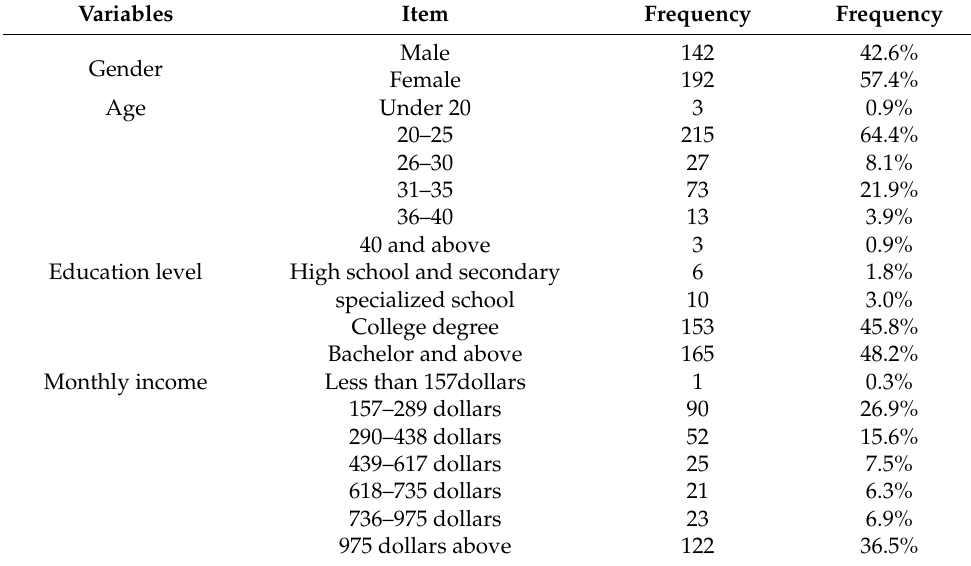
Table 1. Consumer